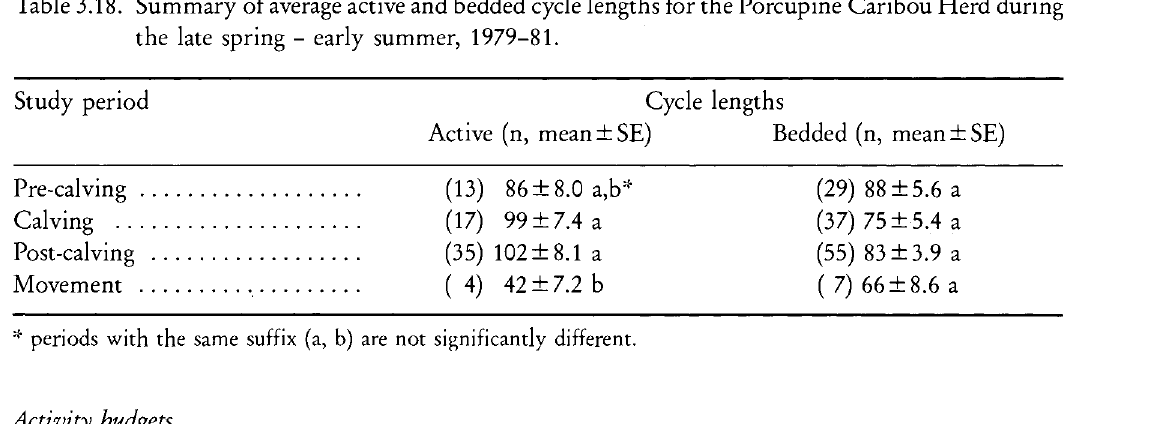
Table 3.18. Summary of average active and bedded cycle lengths for the Porcupine Caribou Herd during the late spring - early summer,